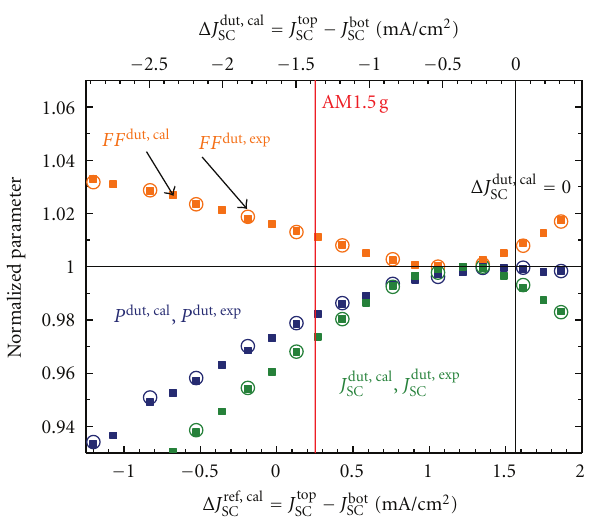
F 11: To prove the method, measured data of the